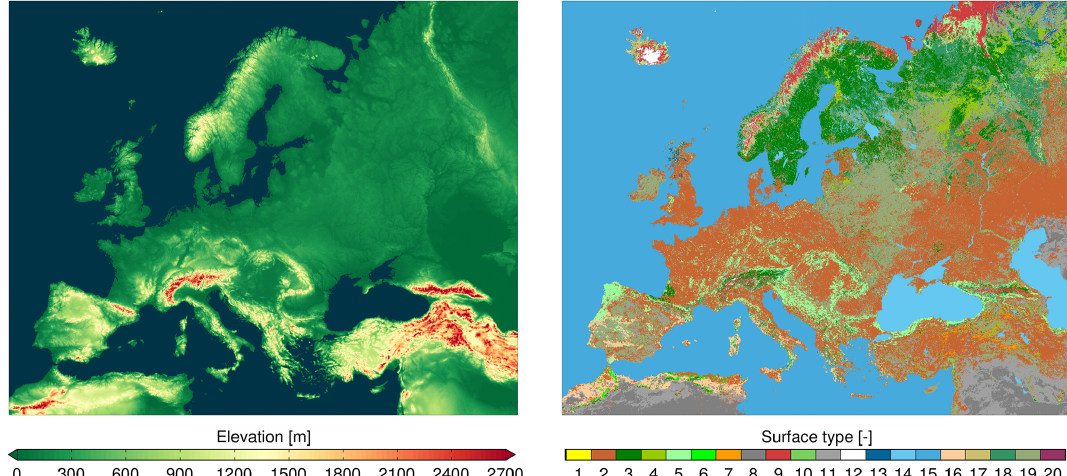
Figure 6. USGS GMTED2010 elevation and GLCC surface type (Biosphere Atmosphere Transfer Scheme Legend) with 0.05 ◦ resolution using the example of Europe. The Biosphere Atmosphere Transfer Scheme Legend comprises the following surface types (United States Ge- ological Survey, 2018a): 1 crops, mixed farming; 2 short grass; 3 evergreen needleleaf trees; 4 deciduous needleleaf trees; 5 deciduous broadleaf trees; 6 evergreen broadleaf trees; 7 tall grass; 8 desert; 9 tundra; 10 irrigated crops; 11 semidesert; 12 ice caps and glaciers; 13 bogs and marshes; 14 inland water; 15 ocean; 16 evergreen shrubs; 17 deciduous shrubs; 18 mixed forest; 19 forest–field mosaic; 20 wa- ter and land mixtures. In the GMTED2010 data set, ocean areas have been assigned a value of 0 (shown in dark